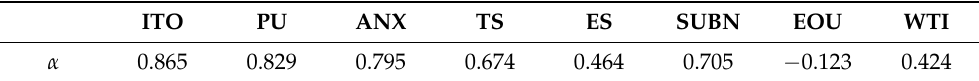
Table 4. Cronbach’s alpha for the categories of the TAM. ANX: anxiety, ES: effort saving, TS: time saving, SUBJN: subjective norm, WTI: willingness to interact.